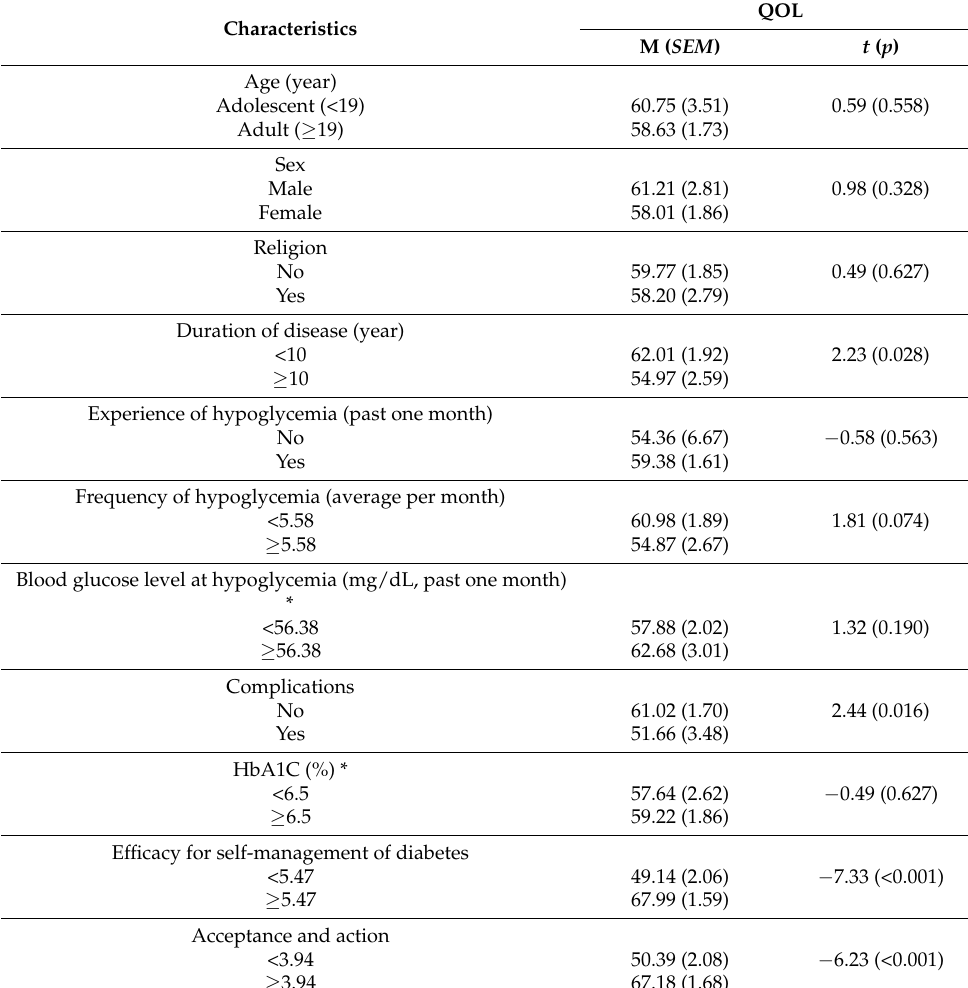
Table 3. Difference of QOL according to Characteristics of the Participants ( N =